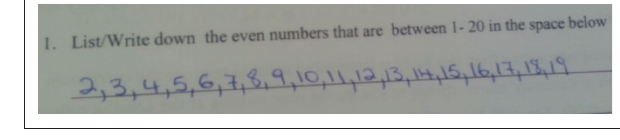
FIGURE 1: Response by Teacher 1.